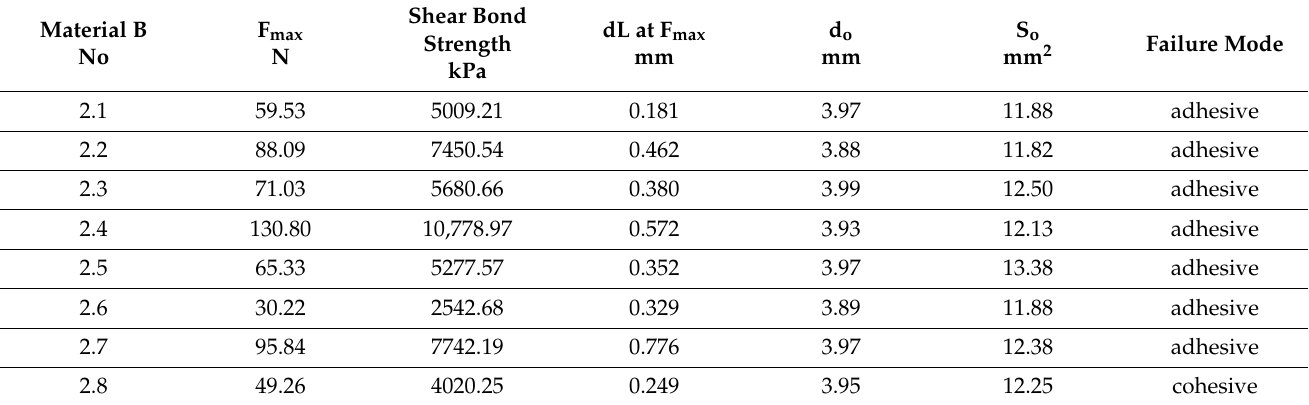
Table 3. The distribution of shear bond strength and failure modes of Ceram X™ (DENTSPLY SIRONA). Material